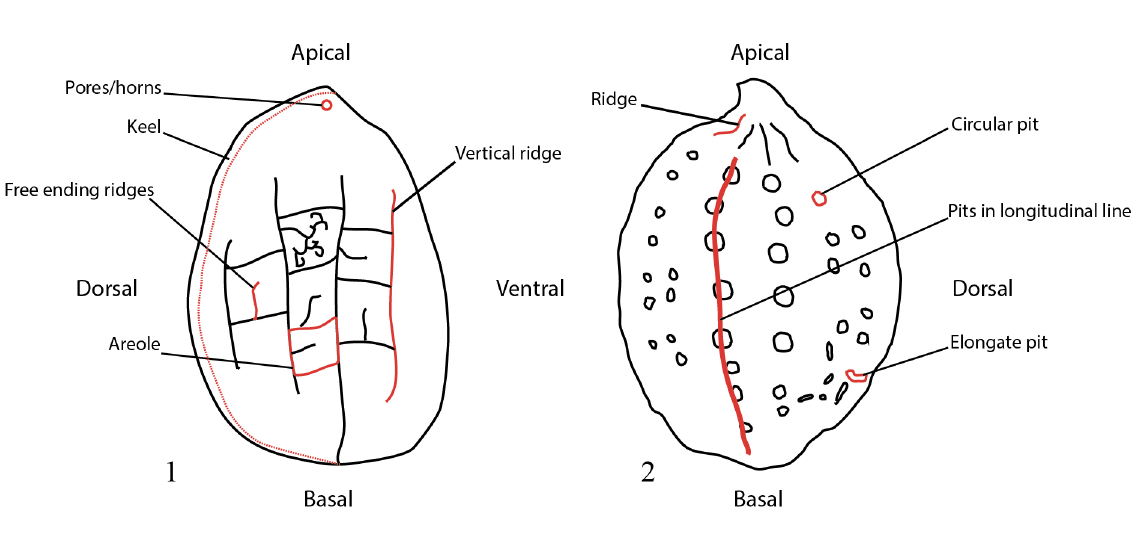
Fig. 1. General ornamentation of Icacinaceae Miers endocarps. 1 . Ridged endocarp. 2 . Pitted endocarp. Image taken from Del Rio